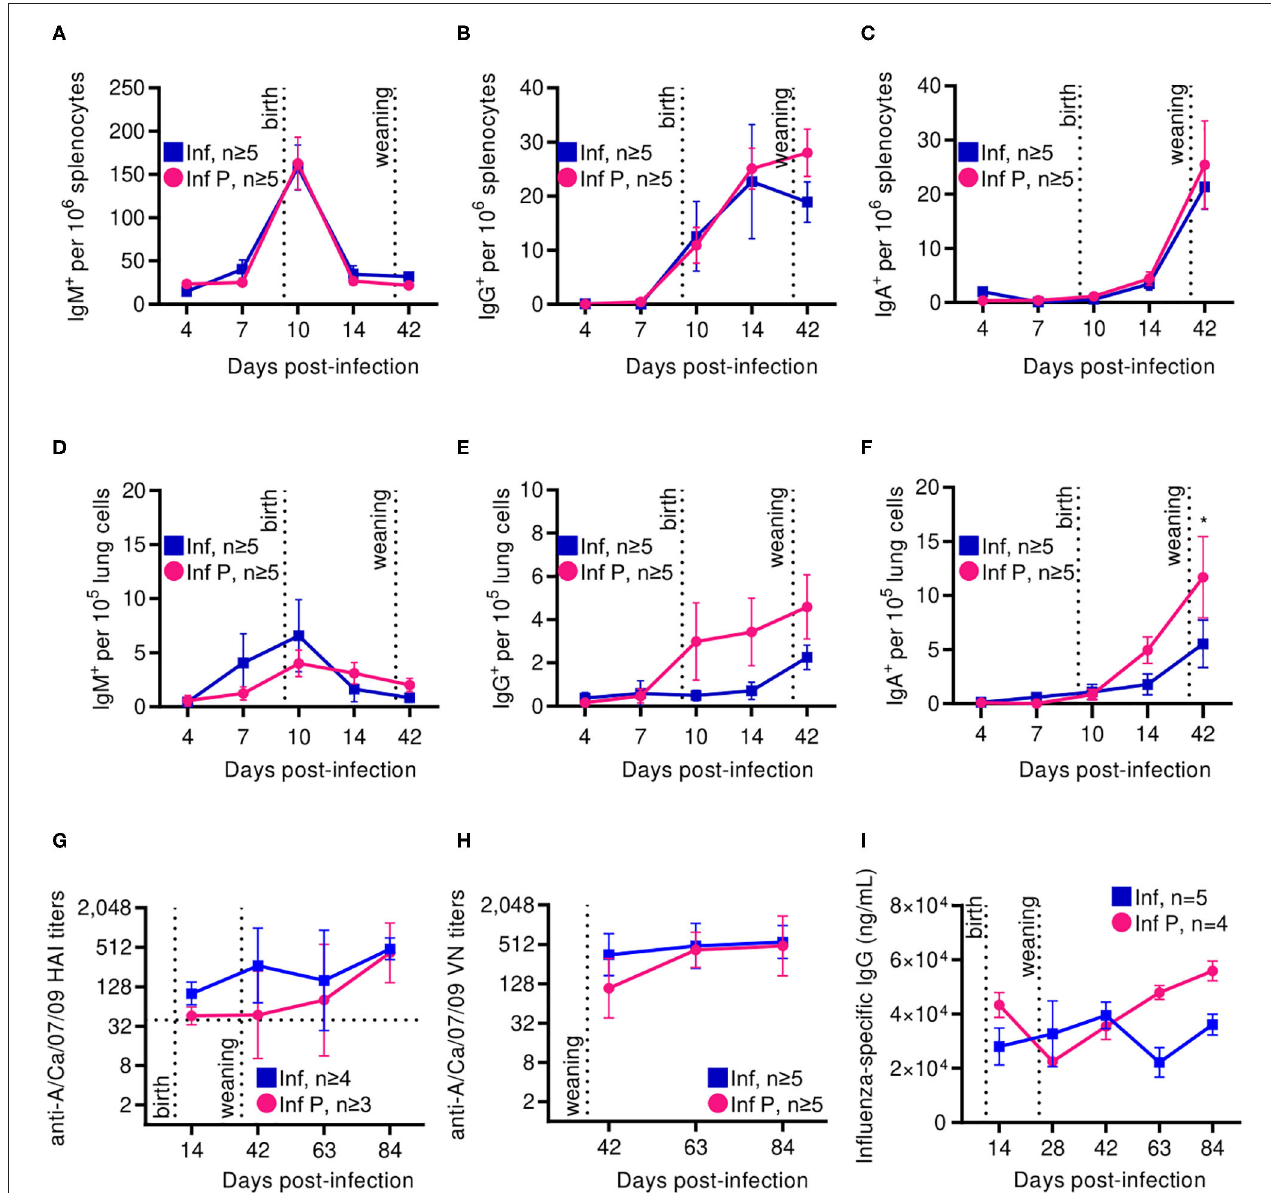
FIGURE 9 | Following delivery, pregnant mice show increased ASCs in spleen and lungs, although these antibodies have lower neutralization and avidity. ASCs were quantified by ELISpot for (A) IgA, (B) IgM, and (C) IgG secretion among splenocytes at days 4, 7, 10, 14, and 42 DPI. ASCs were also quantified for (D) IgA, (E) IgM, and (F) IgG within lungs at the same time points. (G) A/California/07/2009-specific HAI titers were quantified at 14, 42, 63, and 84 DPI. (H) Virus neutralization titers from infected pregnant and non-pregnant animals were assessed against A/California/07/2009 by TCID50. (I) Total IgG titers were determined by ELISA against recombinant HA. All data was analyzed via Two-way ANOVA using Sidak correction for multiple comparisons. Error bars represent Standard Error of Mean (SEM) and mean for (A–F) , and geometric mean with gSD for (G,H) . * p <